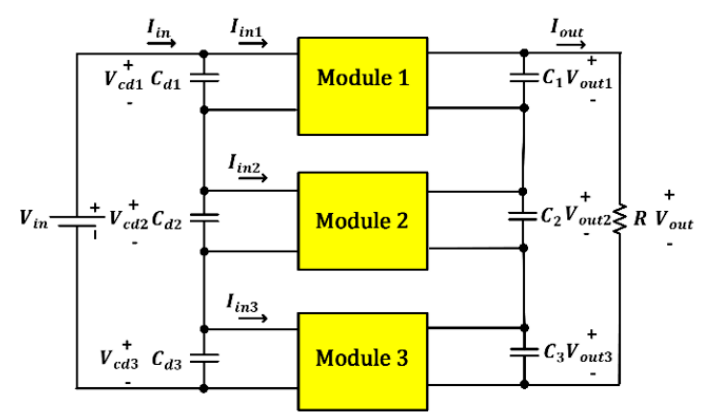
Figure 1. Input-Series Output-Series (ISOS) DC-DC converter circuit diagram.